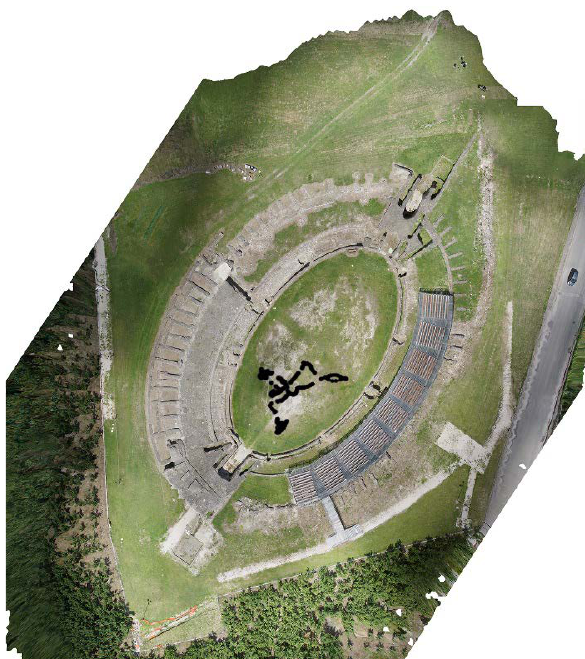
Figure 4: Ortophoto Nadir and camera positions Hexacopter (only Oblique images).